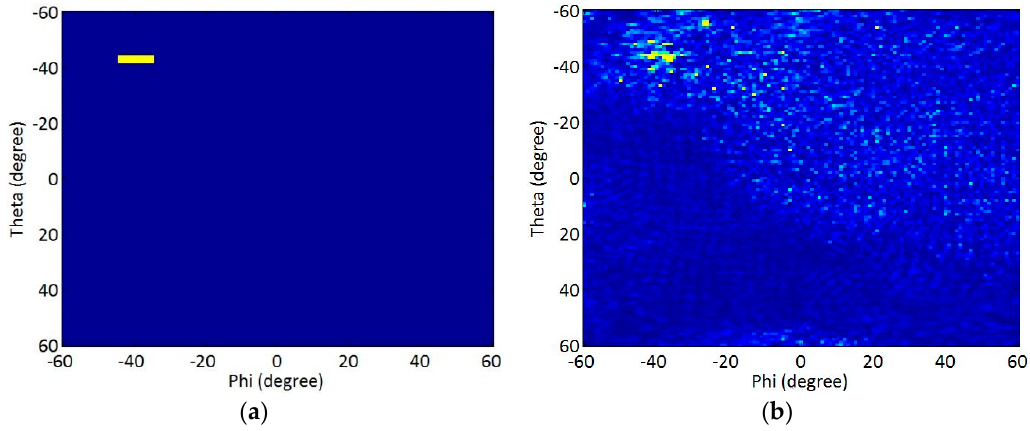
Figure 10. Target scenes: ( a ) true target scene consisting of one metal sheet scatterers; ( b ) the same scene reconstructed by the fabricated MAA.